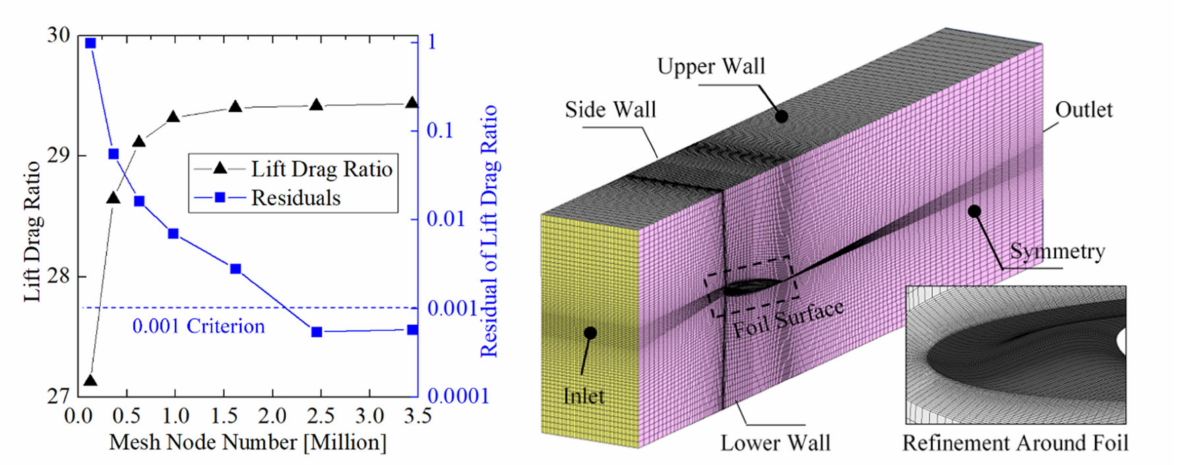
Figure 2. Mesh independence check and the final mesh scheme with the indication of boundaries.